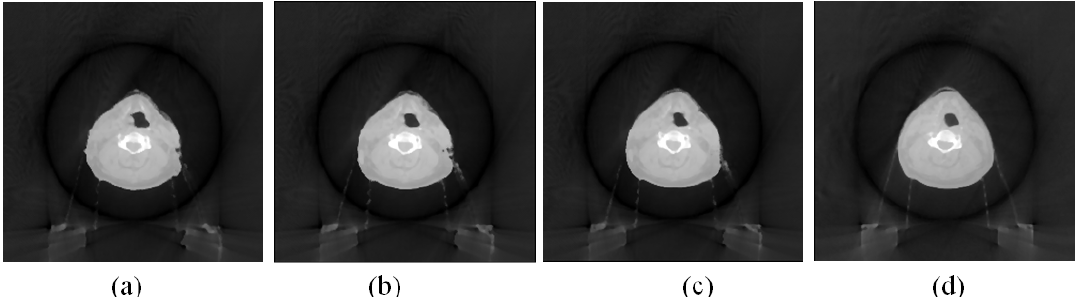
Figure 4. The images reconstructed with the B-spline-based reconstruction method as described in Section 2.3. ( a ) Image reconstructed with 30° scan angle. ( b ) Image reconstructed with 45° scan angle. ( c ) Image reconstructed with 60° scan angle. ( d ) Image reconstructed with 90° scan angle.